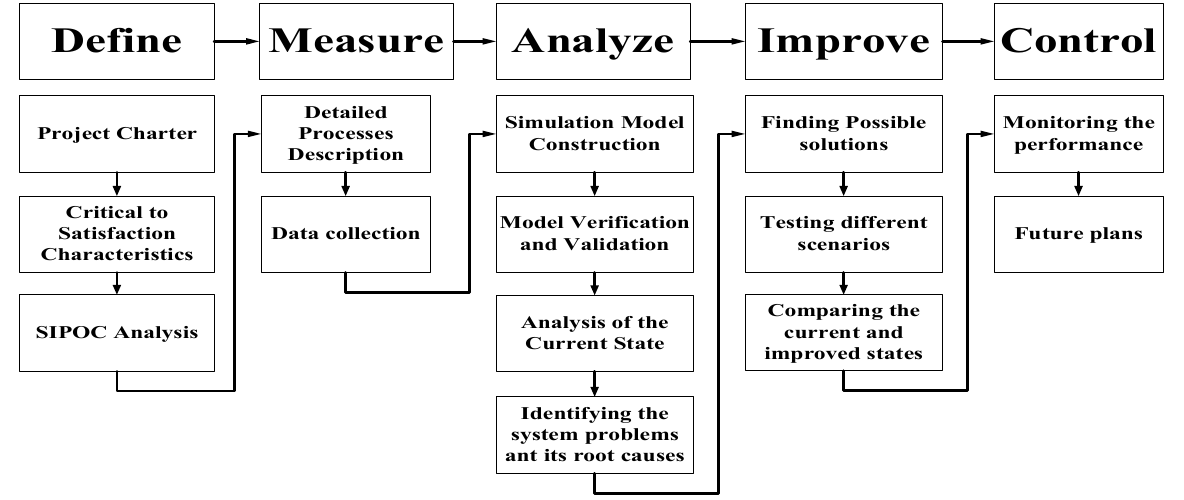
Figure 2. The integrated methodology used in this research.